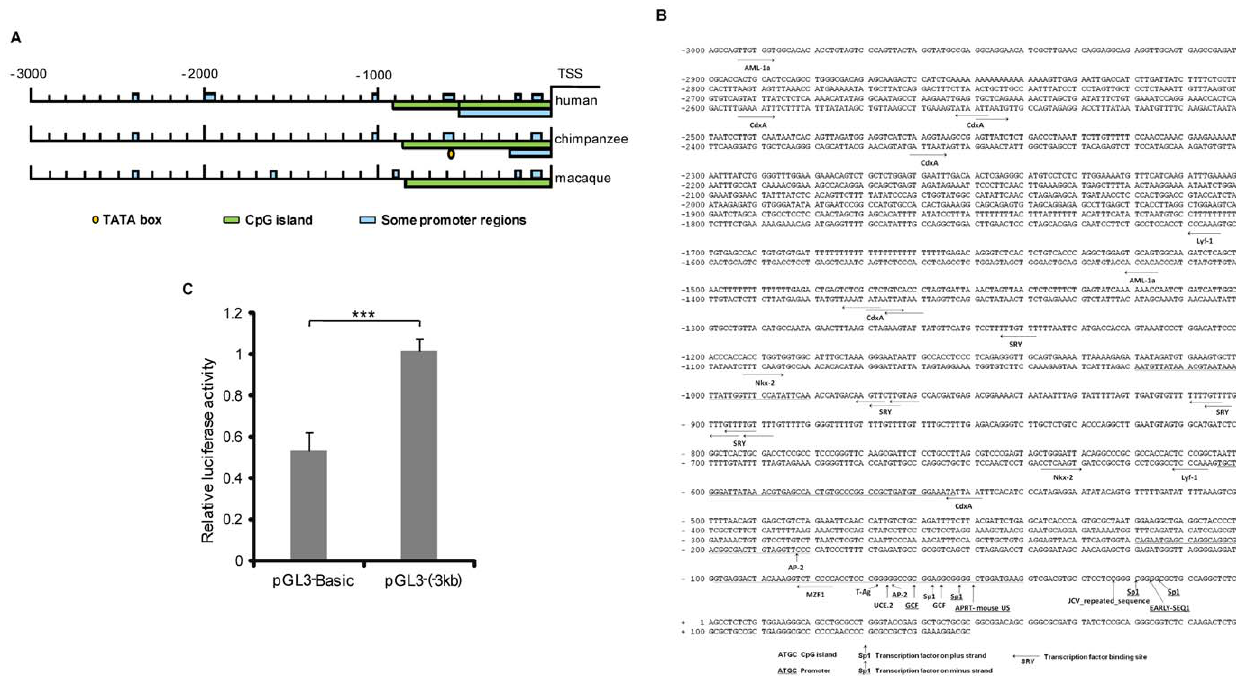
Figure 1. Bioinformatics analysis of the MGARP promoter. A. Promoter analysis comparing the 2 3 kb upstream region of the MGARP gene between three species (Homo sapiens, Pan troglodytes and Macaca mulatta). B. A summarized display of the 2 3 kb upstream region in the human MGARP promoter with predicted promoter and transcription factor (TF) binding sites. C. Luciferase (Luc) reporters driven by the 3 Kb MGARP promoter (pGL3-( 2 3 kb)) and the promoter-less control (pGL3-Basic) were transfected into HEK-293T cells and analysis was carried out as described in Materials and Methods. *** represents p , 0.001 and # represents p . 0.05 (no significant difference).